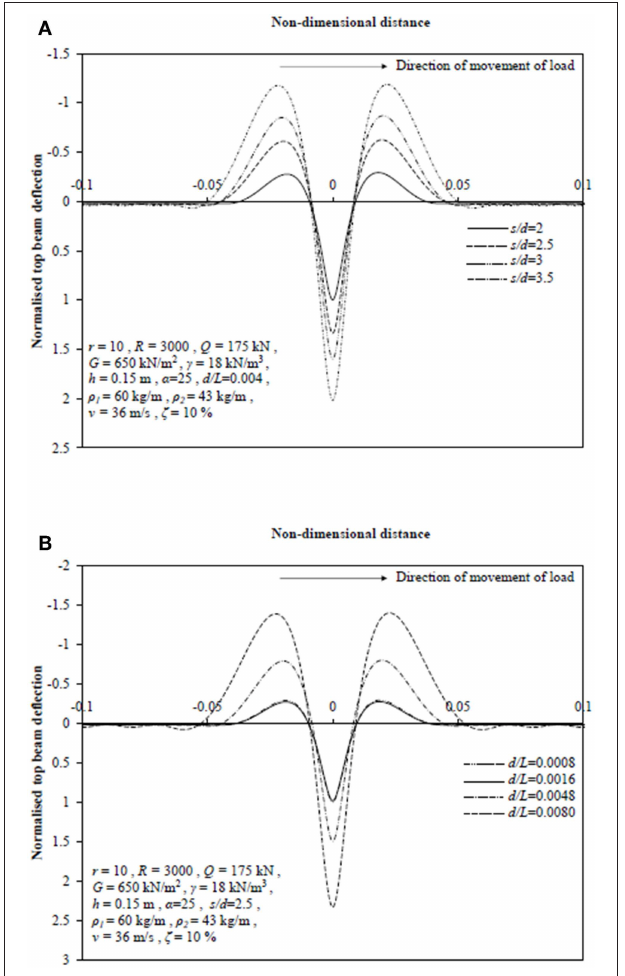
FIGURE 12 | Deflection of top beam for different depths of placement of the bottom beam.